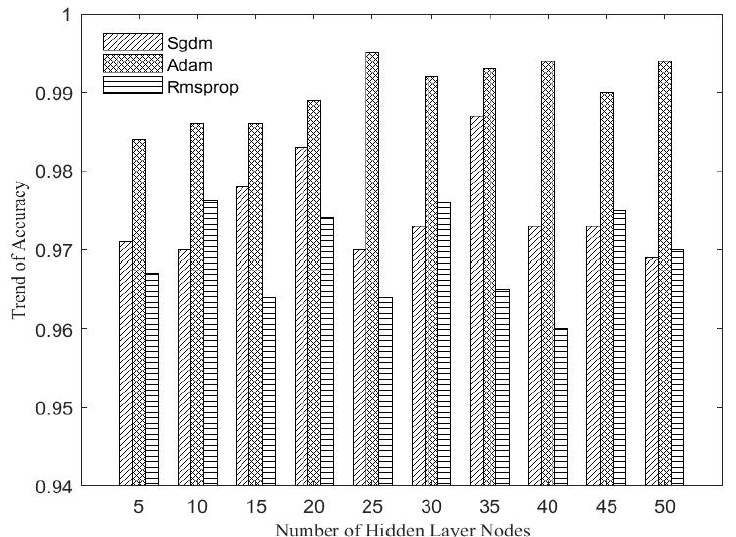
Figure 9. Classification accuracy with different optimization functions.